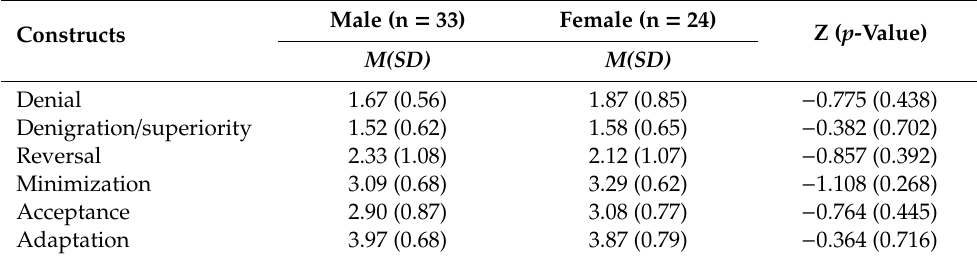
Table 7. Gender-related di ff erences of IRSSQ